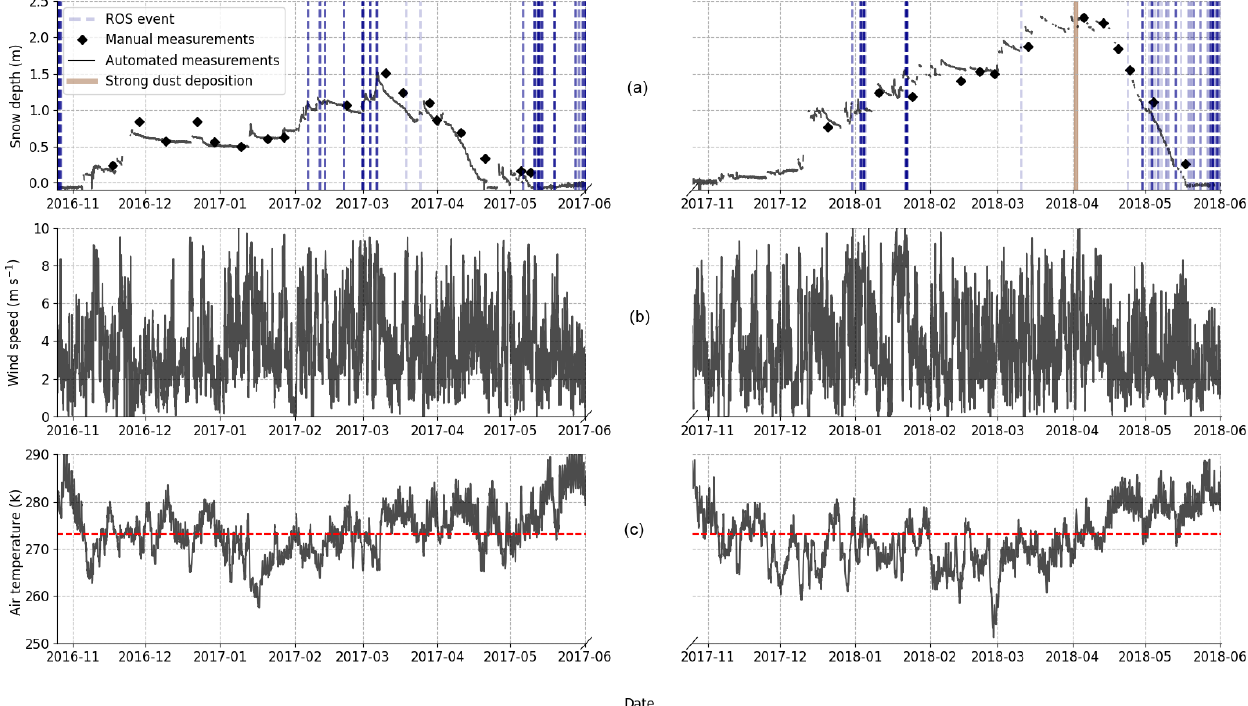
Figure 2. Snow depth (a) , wind speed (b) and air temperature (c) measured at the weather station for the two snow seasons (black curve). All data are averaged at an hourly time step. In panel (a) , ROS and strong dust deposition events are represented by dashed blue and brown shading, respectively. Manual snow depth measurements acquired on each field day are also represented by black diamonds. The tick on the abscissa axis corresponds to the first day of each month.